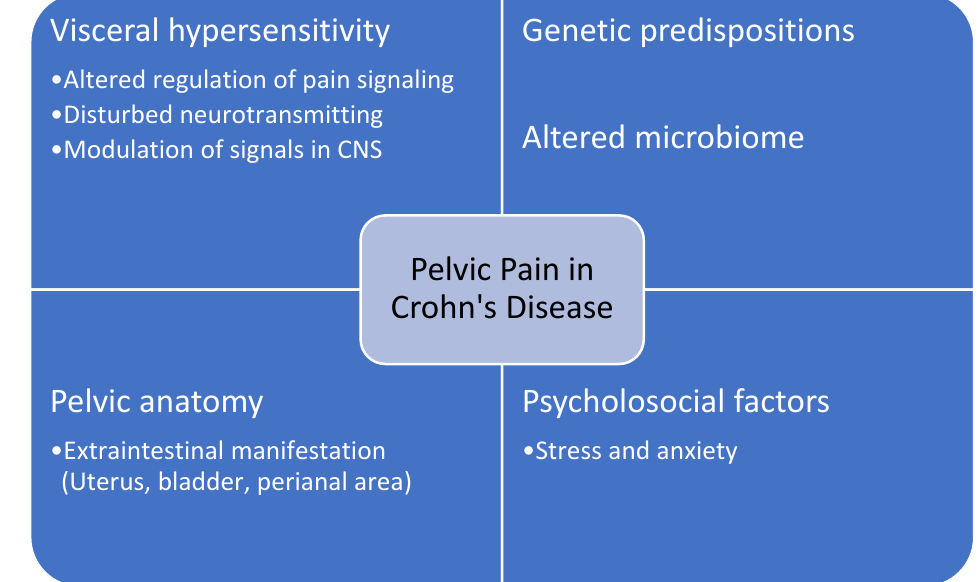
Figure 1. Summary of the pathogenesis of pelvic pain in CD.